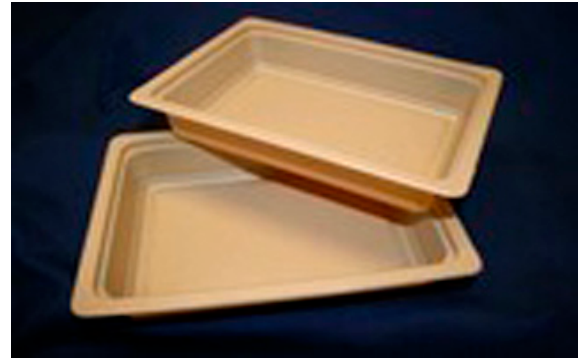
Figure 15. Food packaging from PLA and wood fibres [116].